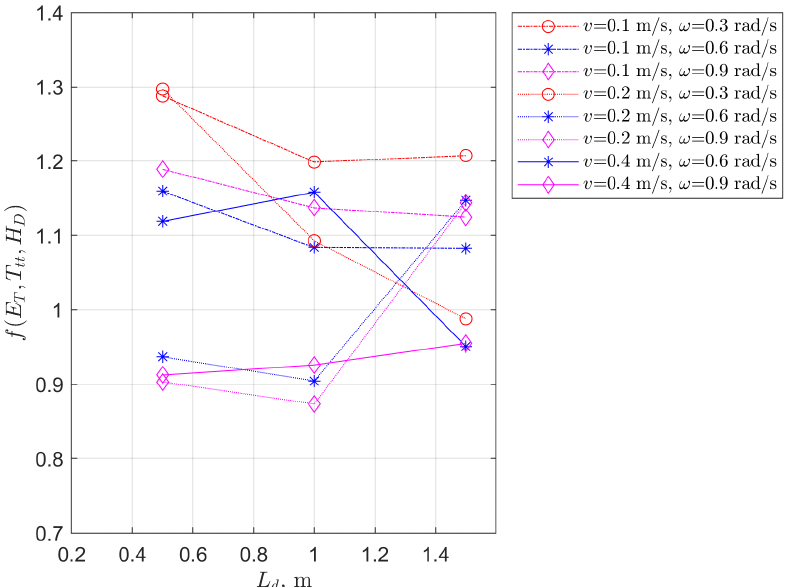
Figure 8. Cost function vs. look ahead distance for selected values of the linear speed and maximum angular rate—track